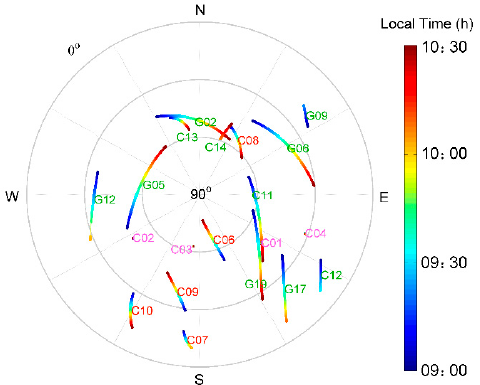
Figure 2. Sky plots on DOY 310 (6 November 2018) from 9:00 a.m. to 10:30 a.m. local on time and observation time spans for each satellite, satellite number in different colors represent type of orbits, for GEO in magenta, IGSO in red, and MEO in green.